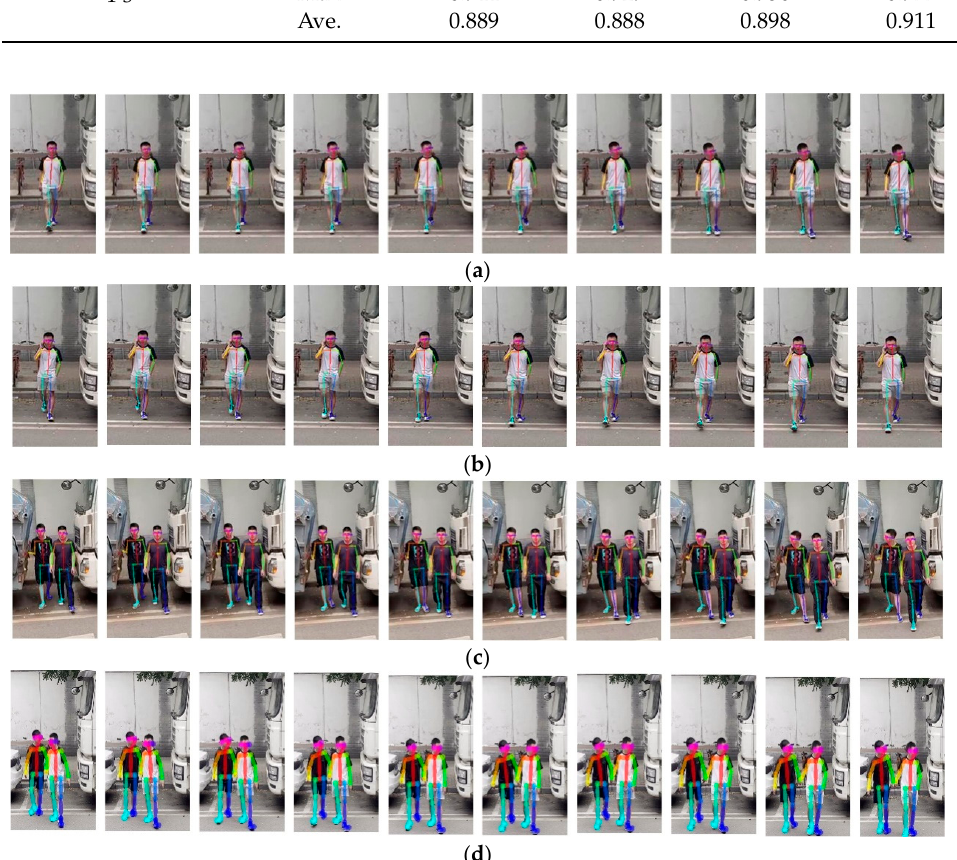
Figure 13. Pedestrian hazardous crossing intention prediction experiment: ( a ) single person does not have a hazardous crossing intention, ( b ) single person has hazardous crossing intention, ( c ) pedestrians have hazardous crossing intention, and ( d ) pedestrians do not have hazardous crossing intention.